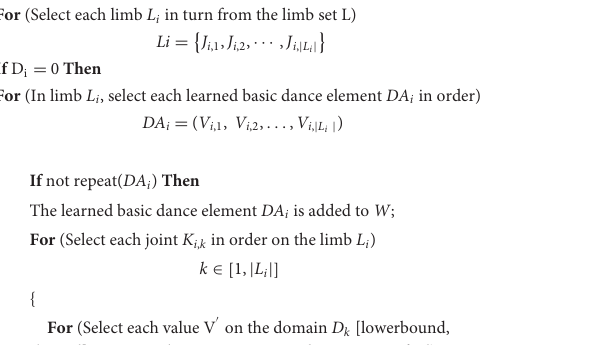
Algorithm 1 | Algorithm flow of the new dance element imagination based on the change of single joint value. For (Select each limb L i in turn from the limb set